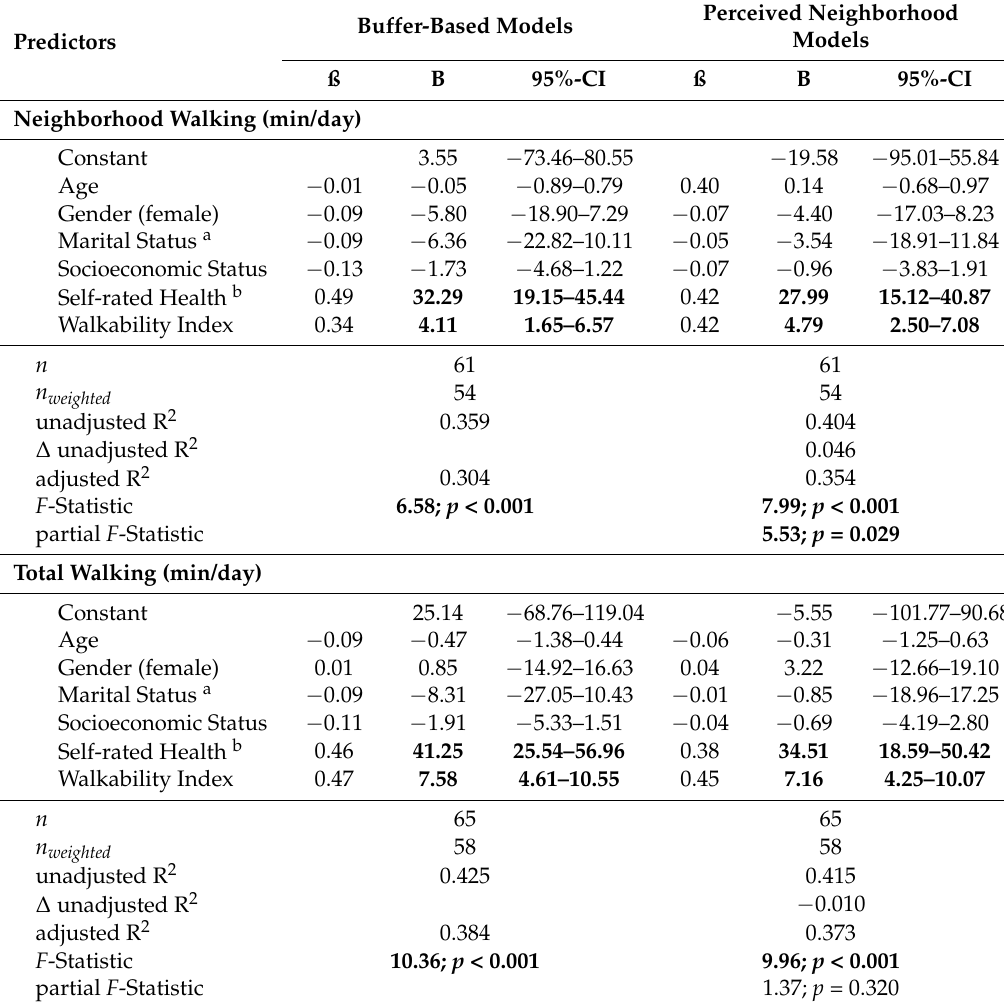
Table 2. Buffer-based and perceived neighborhood-based regression models for